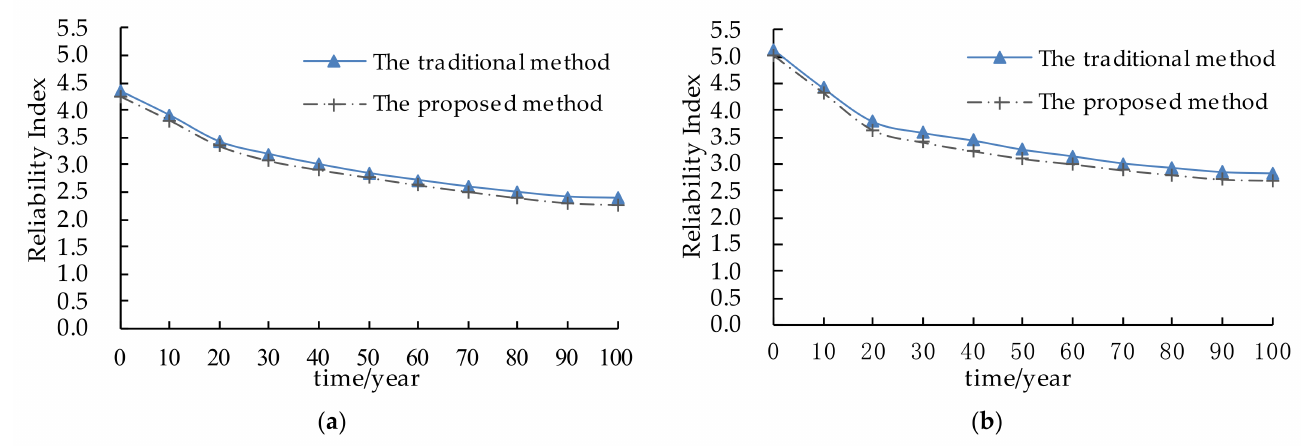
Figure 8. Time-dependent reliability of simply supported T-beam bridge: ( a ) Beam 1; ( b ) Beam